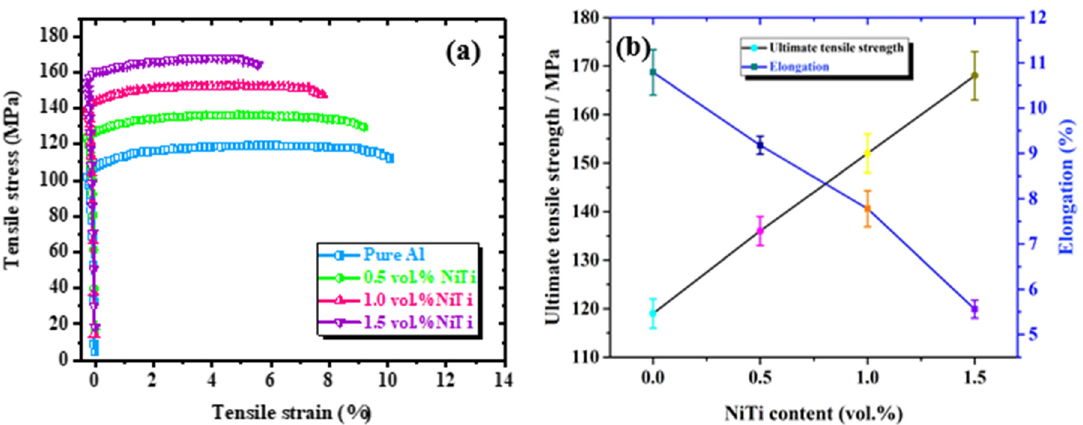
Figure 4. ( a ) Typical tensile stress–strain curves and ( b ) ultimate tensile strength and ductility for pure Al and Al-NiTi